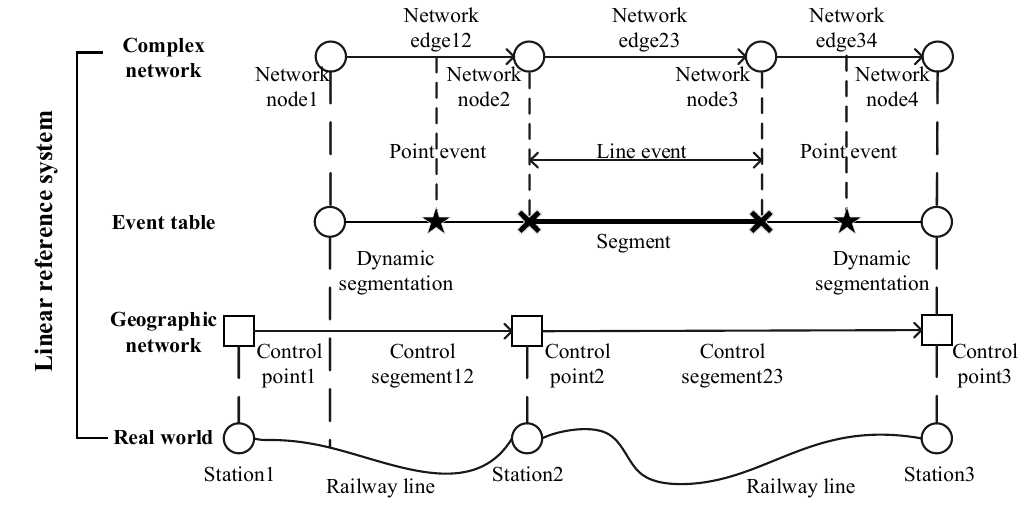
Figure 1. The geographic railway network conceptual model.